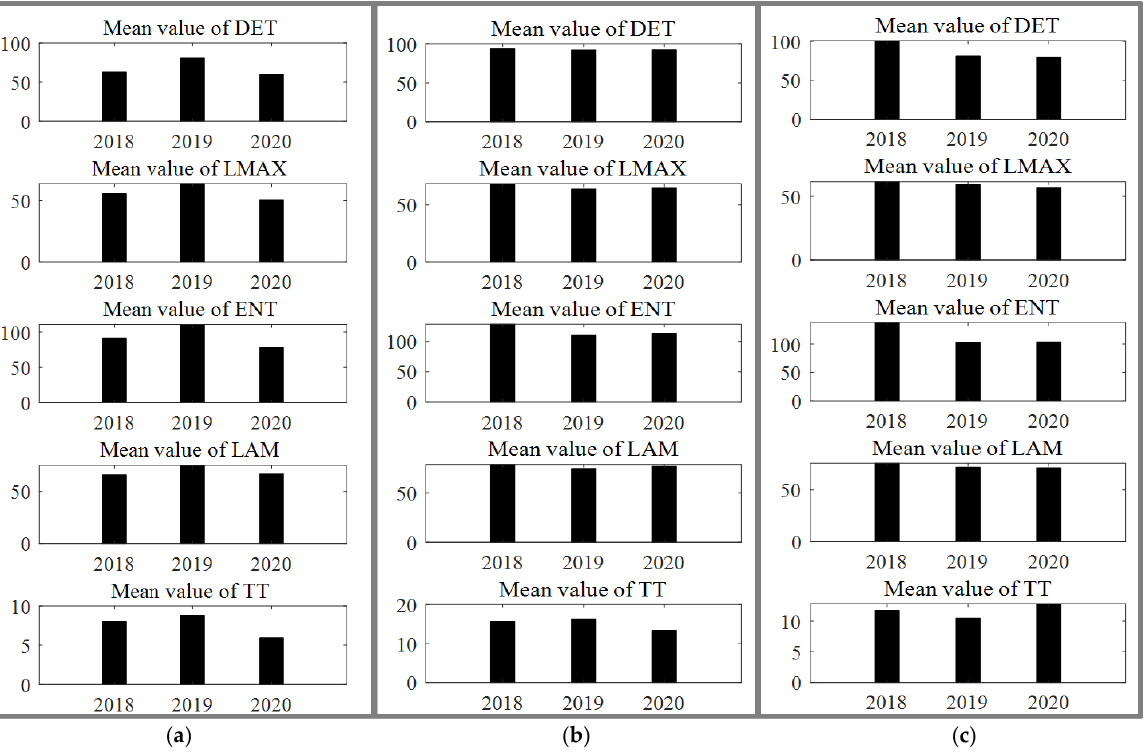
Figure 4. RQA indicators for cities under different epidemic conditions. (Note: ( a ) represents 12 cities with severe epidemics; ( b ) represents 24 cities with few confirmed cases; ( c ) represents 5 cities with secondary outbreaks. The Y − axis indicates the value of the RQA index, and the X − axis indicates the year.)